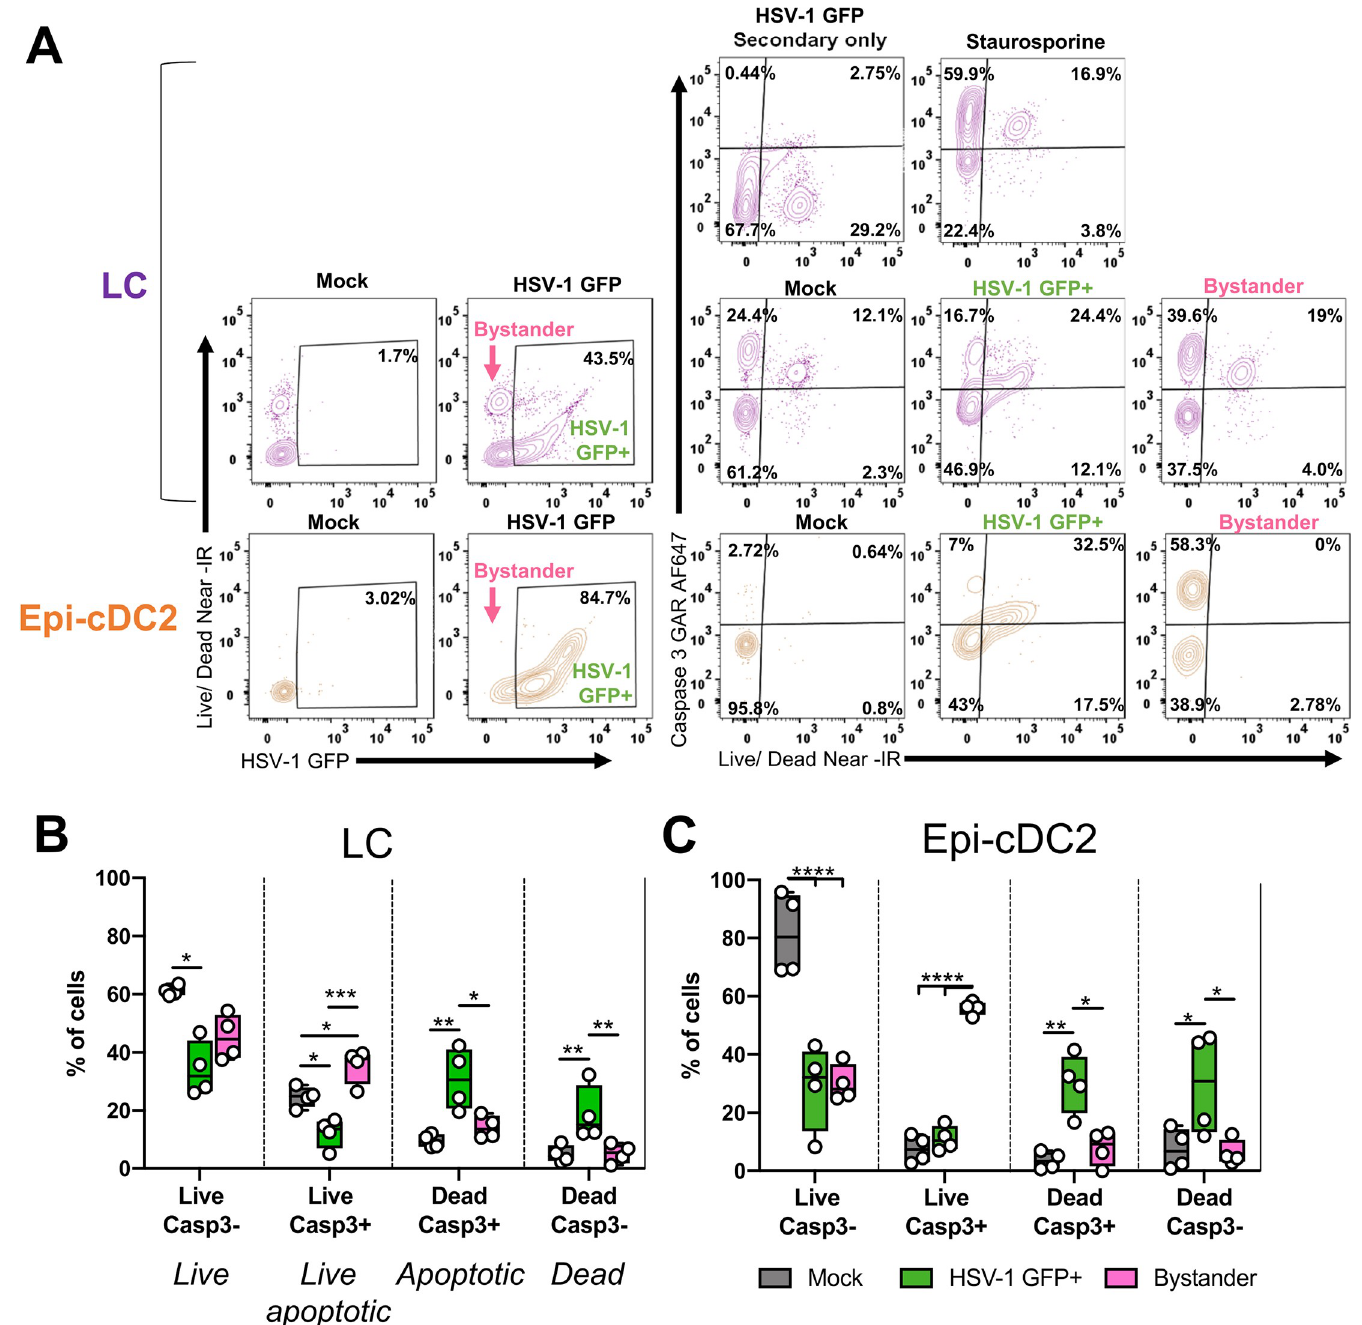
Fig 9. HSV-1 induces apoptosis of both infected and bystander LCs and Epi-cDC2s. Epidermal MNPs were isolated from human abdominal epidermis and inoculated with HSV-1 GFP (MOI of 10) or mock treated, then washed and incubated for a total infection time of 18 h. As a positive control, some cells were treated with 1 μ M staurosporine for 18 h at 37˚C. The cells were labelled for flow cytometry as in Fig 2, as well as with intracellular active Caspase-3 (Casp3) and LIVE/DEAD Near-IR for examining apoptosis. (A) Representative plots showing apoptosis analysis. In the HSV-1 infected conditions, LCs and Epi-cDC2s were first separated into HSV-1 GFP+ and Bystander (HSV-1 GFP-) populations including live and dead cells. Apoptosis was assessed in mock, HSV-1 GFP and staurosporine treated conditions by analyzing the distribution of cells over the four Casp3 vs. Live/Dead quadrants, with gates set according to the mock and staurosporine conditions. Live Casp3-: live cells , Live Casp3+: live apoptotic cells , Dead Casp3+: apoptotic cells , Dead Casp3-: dead cells . (B and C) Grouped analyses of the percentage of LCs and Epi-cDC2s (respectively) in each of the apoptosis quadrants in mock (grey), HSV-1 GFP+ (green) and Bystander (pink) populations shown as box and whisker plots. Repeated measures one-way ANOVA with Tukey’s test for multiple pairwise comparisons was used to compare the percentage of LCs (B) or Epi-cDC2s (C) in each apoptosis quadrant between mock, HSV-1 GFP+ and bystander populations, n = 4. (B) Live cells : Mock vs. HSV-1+ p = 0.0100, Live apoptotic cells : Mock vs. HSV-1+ p = 0.0140,